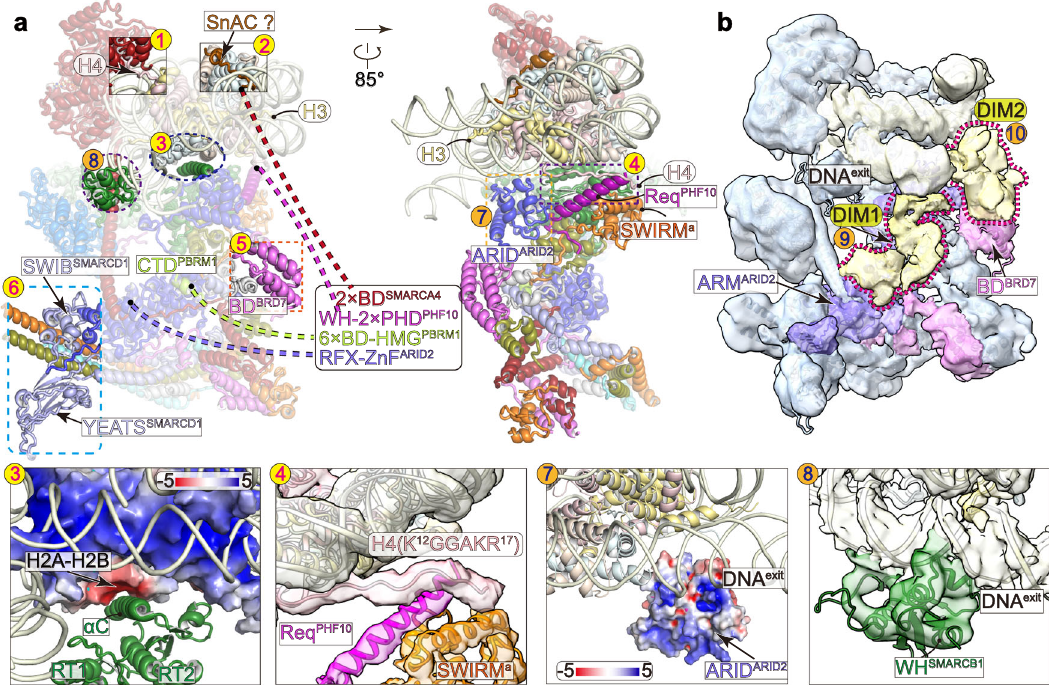
Fig. 4 | Histone/DNA-binding domains/modules. a Structural model and b cryo- EM map at low threshold of PBAF-NCP with the positions of histone/DNA-binding domains/modules indicated with numbers. Numbers 1 to 6 in yellow balls indicate the histone-binding domains and 7 to 10 in orange balls indicate the DNA-binding domains/modules. Invisible domains are connected with dashed lines to indicate